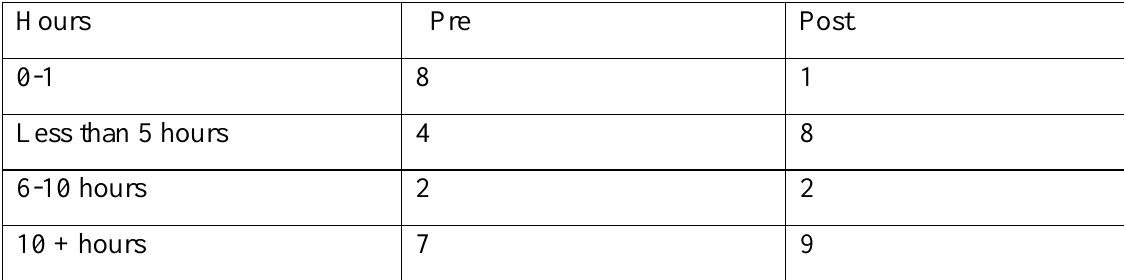
Table 2: Frequency of Using Technology (hours)